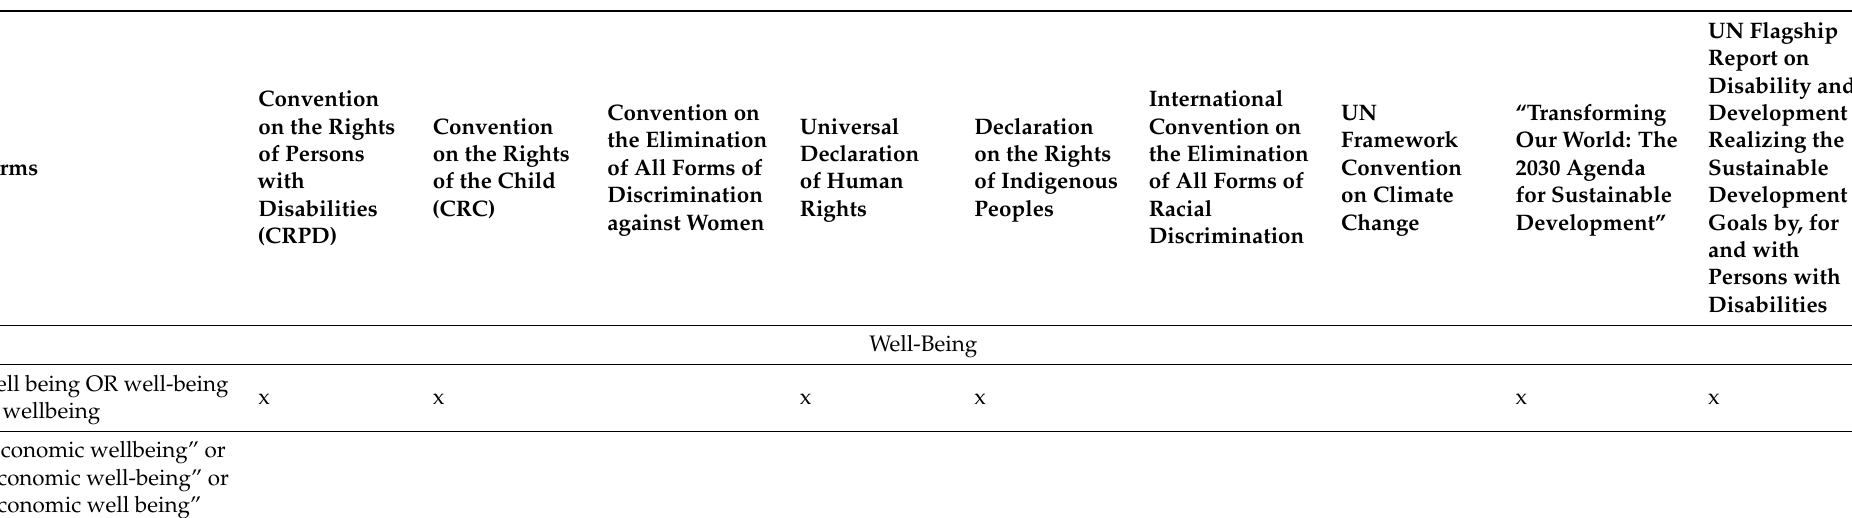
Table 3. hit counts for other social indicators from existing literature [103–141] in the actual document such as the